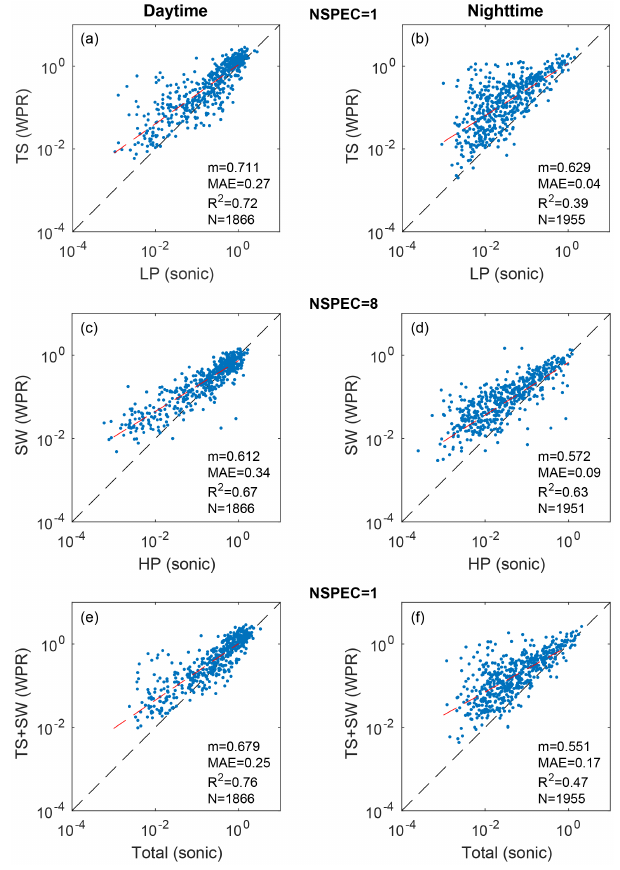
Figure 9. Same as in Fig. 5 but separated by daytime (a, c, e) and nighttime (b, d, f) , with the respective NSPECs shown.